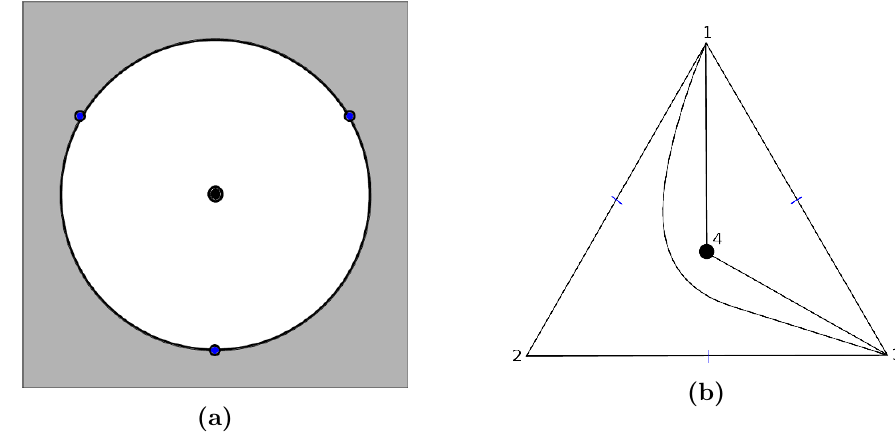
Figure 14. (a): CP 1 n D 1 where D 1 is a disk around z = 1 bounded by S 1 with three marked points colored in blue. The regular singularity at z = 0 is colored in black. (b): a triangulation in the ( A 1 ; D 3 ) Argyres-Douglas theory. There are three boundary edges. The blue marks correspond to the positions of three Stokes